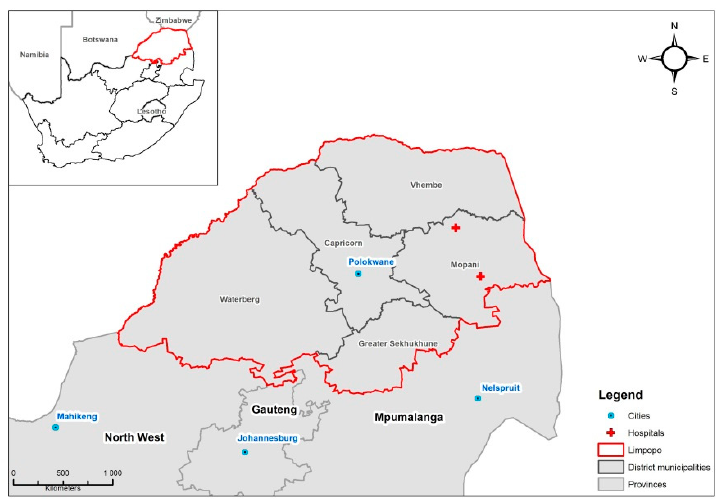
Figure 1. Location of the two hospitals and meteorological stations in the study site in Limpopo Province, South Africa.